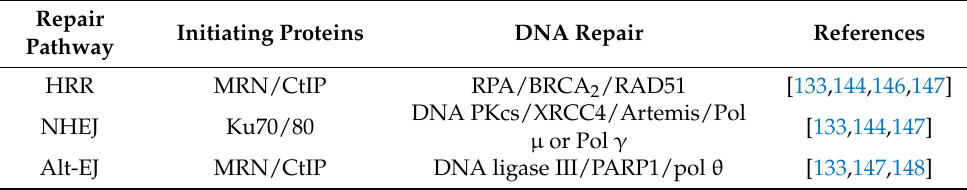
Table 4. Comparison of enzymes in different DNA repair